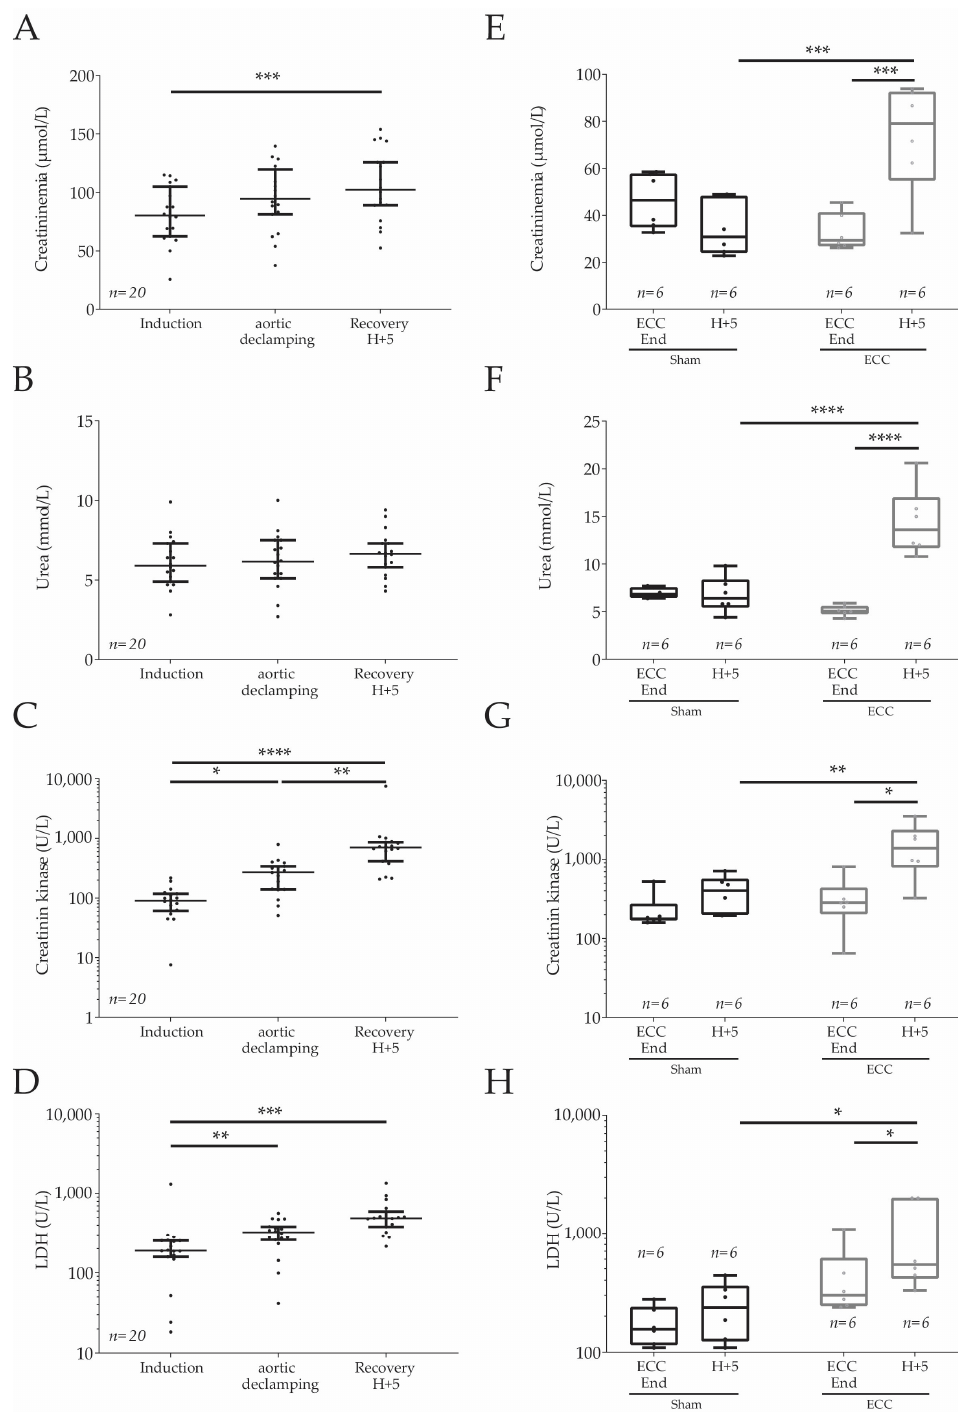
Figure 2. Plasmatic measure of renal markers and stress markers from human and rat arterial blood. The plasma samples were recovered from human blood ( A – D ) at the induction of anesthesia, the aortic declamping, and 5 h post-declamping during recovery and from rats ( E – H ) at the start of ECC, at the ECC end, and 5 h postoperatively (H+5). The renal markers measured were creatinemia (µmol/L, panels ( A , E )) and urea (mmol/L; panels ( B , F )). Stress was evaluated with the measure of lactate dehydrogenase or LDH (U/L; panels ( C , G )) and creatine kinase (U/L, panels ( D , H )). Statistical analyses were made with paired tests, one-way ANOVA for humans ( A – D ) with Dunn’s post-hoc test, and a two-way ANOVA test with Sidak’s multiple comparisons test for rats. * p < 0.05, ** p < 0.01, *** p < 0.001, **** p < 0.0001.